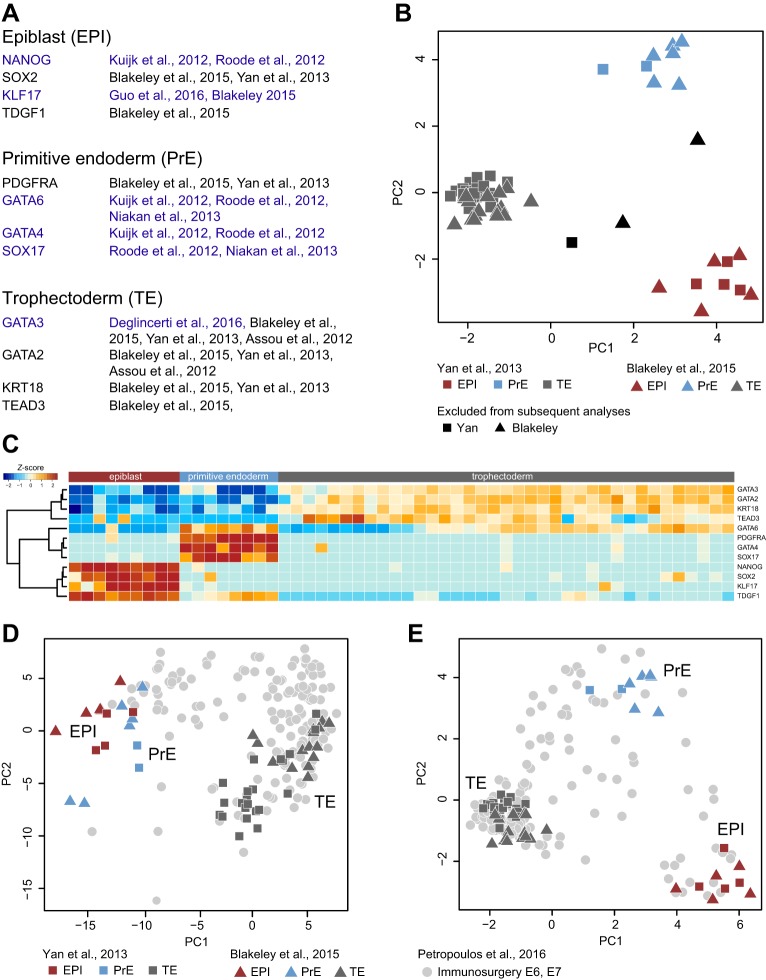
Lineage segregation based on marker genes. (A) Panel of 12 high-confidence markers for EPI, PrE and TE. Publications with immunofluorescence data showing protein expression in the human blastocyst are highlighted in blue. A subset of TE cells express CDX2 in human (Chen et al., 2009; Niakan and Eggan, 2013). (B) PCA of embryo cells profiled in the Yan and Blakeley studies based on lineage markers. (C) Hierarchical clustering of Yan and Blakeley datasets. (D,E) PCA of EPI, PrE and TE with E6 and E7 Petropoulos immunosurgery samples (grey) based on common variable genes (n=188, log2 FPKM>2, log CV2>0.5) (D) or based on lineage markers (E).